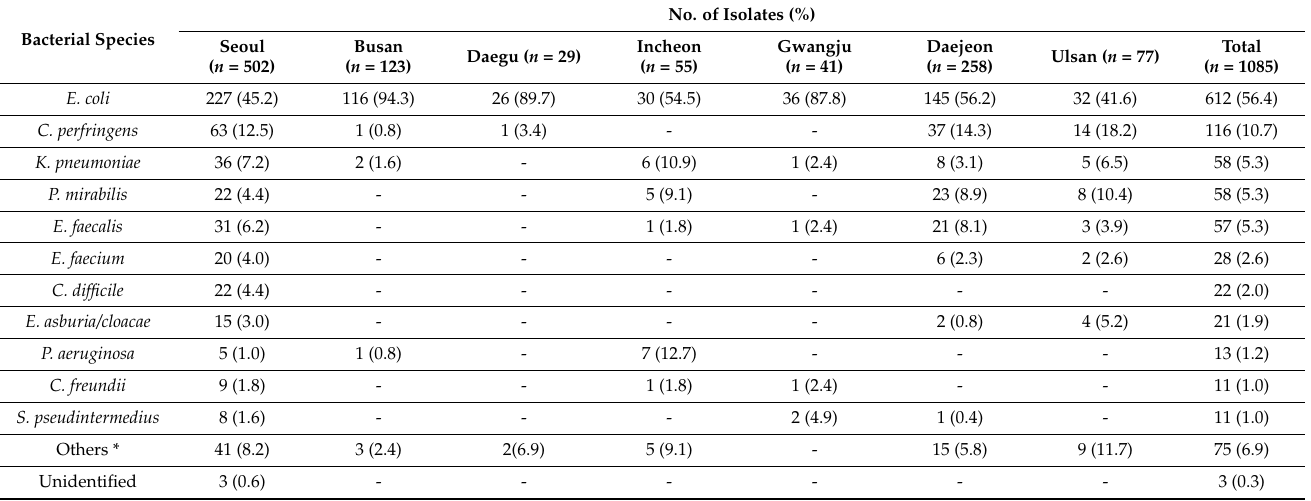
Table 2. Recovered isolate prevalence in diarrheal stool of dogs during nationwide